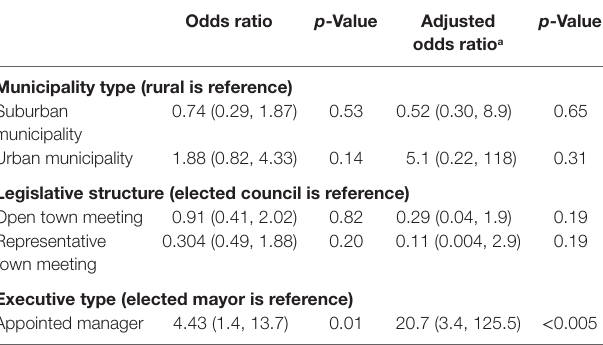
TaBle 4 | Demographic and organizational characteristics associated with service sharing.